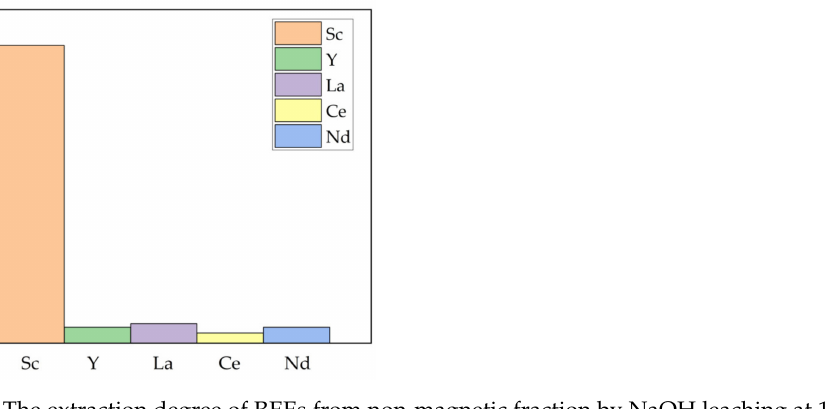
Figure 4. The extraction degree of REEs from non-magnetic fraction by NaOH leaching at 110 ◦ C, L/S ratio = 10, C NaOH 11.6 mol L − 1 , and leaching time 25 min.